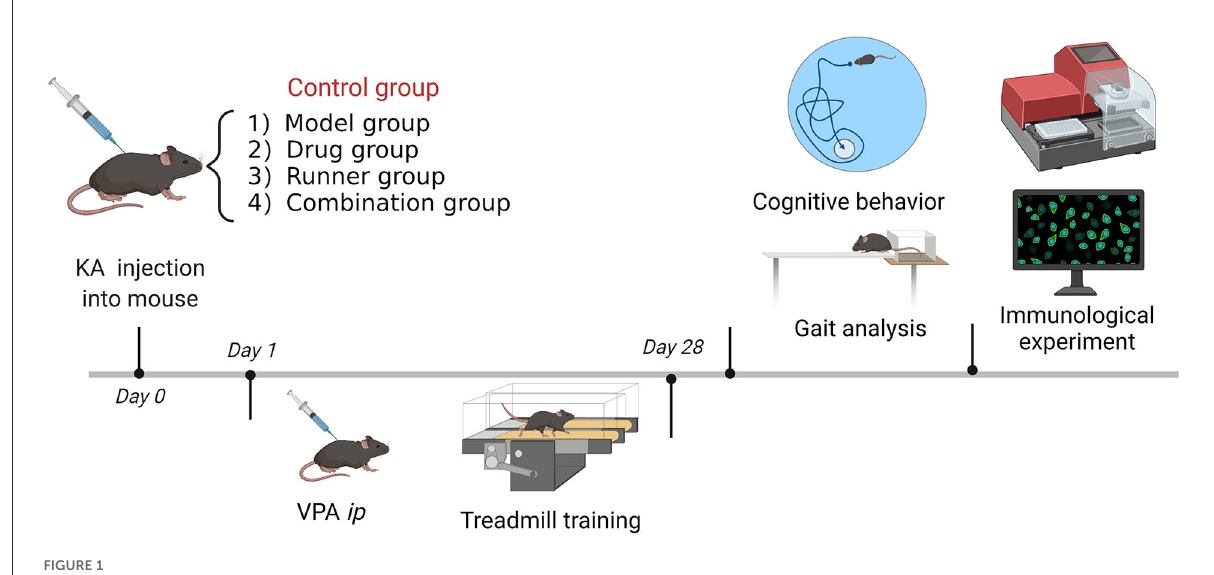
FIGURE1 Flowchart of the